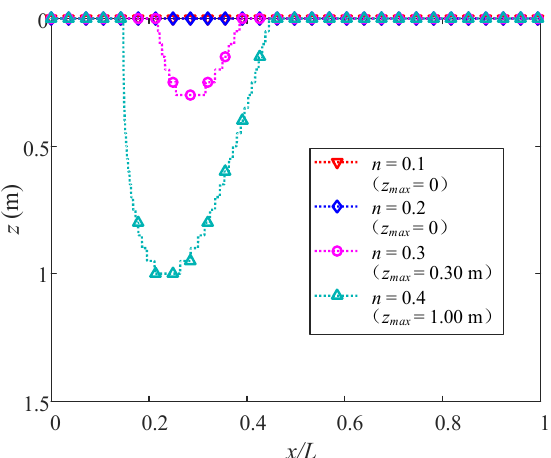
Figure 25. Distributions of maximum liquefaction depth with different porosities.